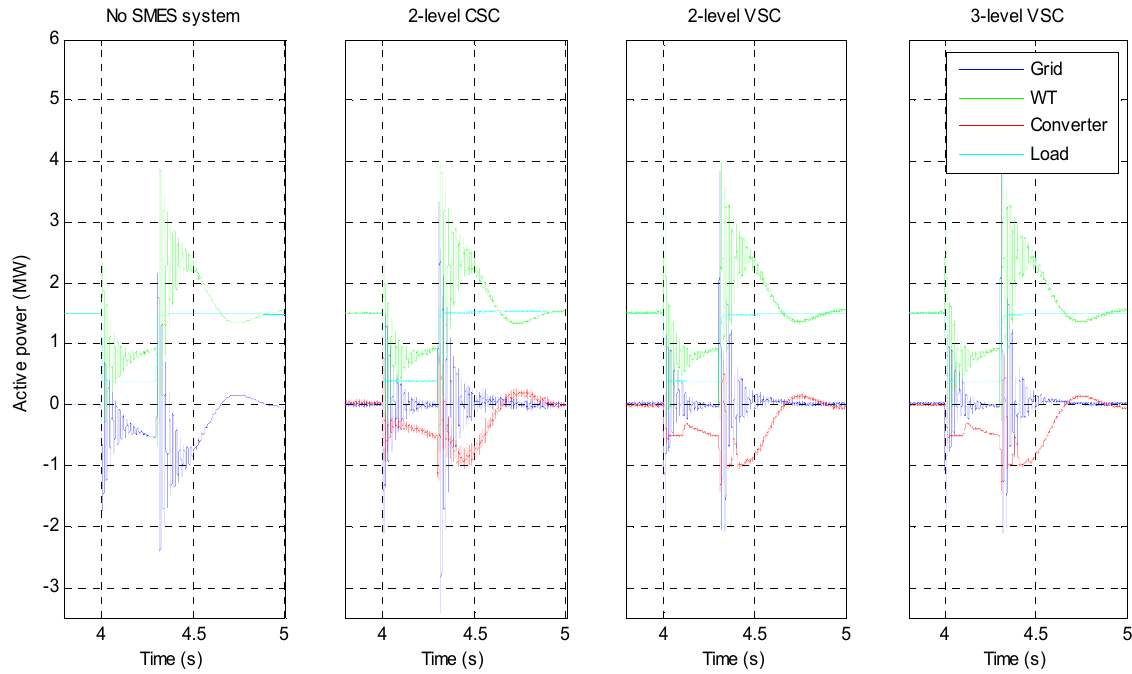
Figure 25. Operation with and without SMES system for grid-support